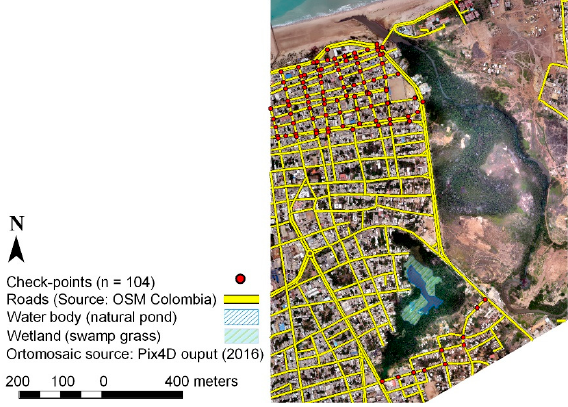
Figure 4. Checkpoint locations for DEM accuracy assessment.